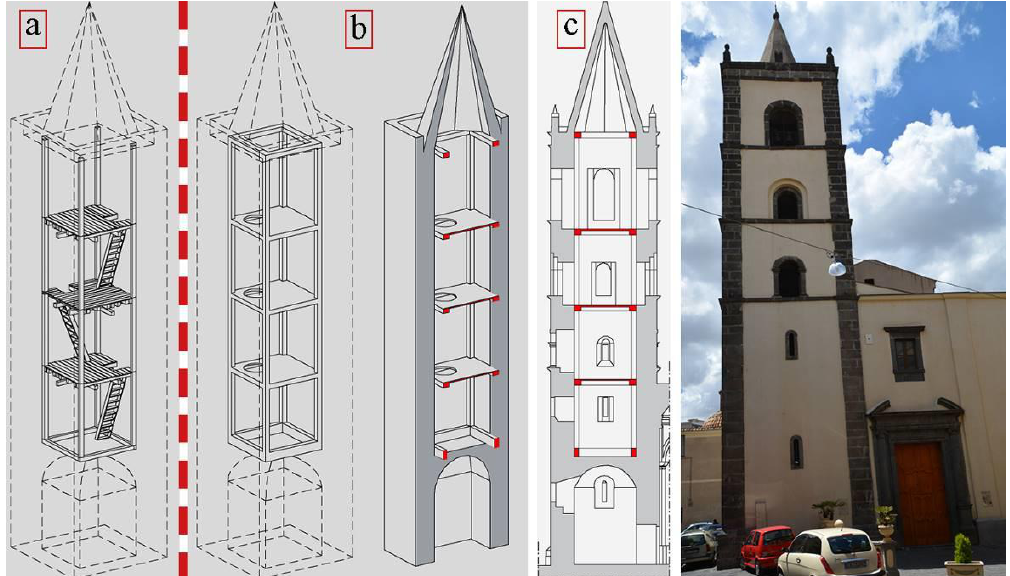
Figure 11. The bell tower of SS. Trinità in Bronte (Ct): a) 3D scheme of one of the hypotheses on the original wooden structure. b) Overall dimensions of the reinforced concrete structure inside the tower: three-dimensional scheme. c) Cross-section of the tower: in red, the reinforced concrete